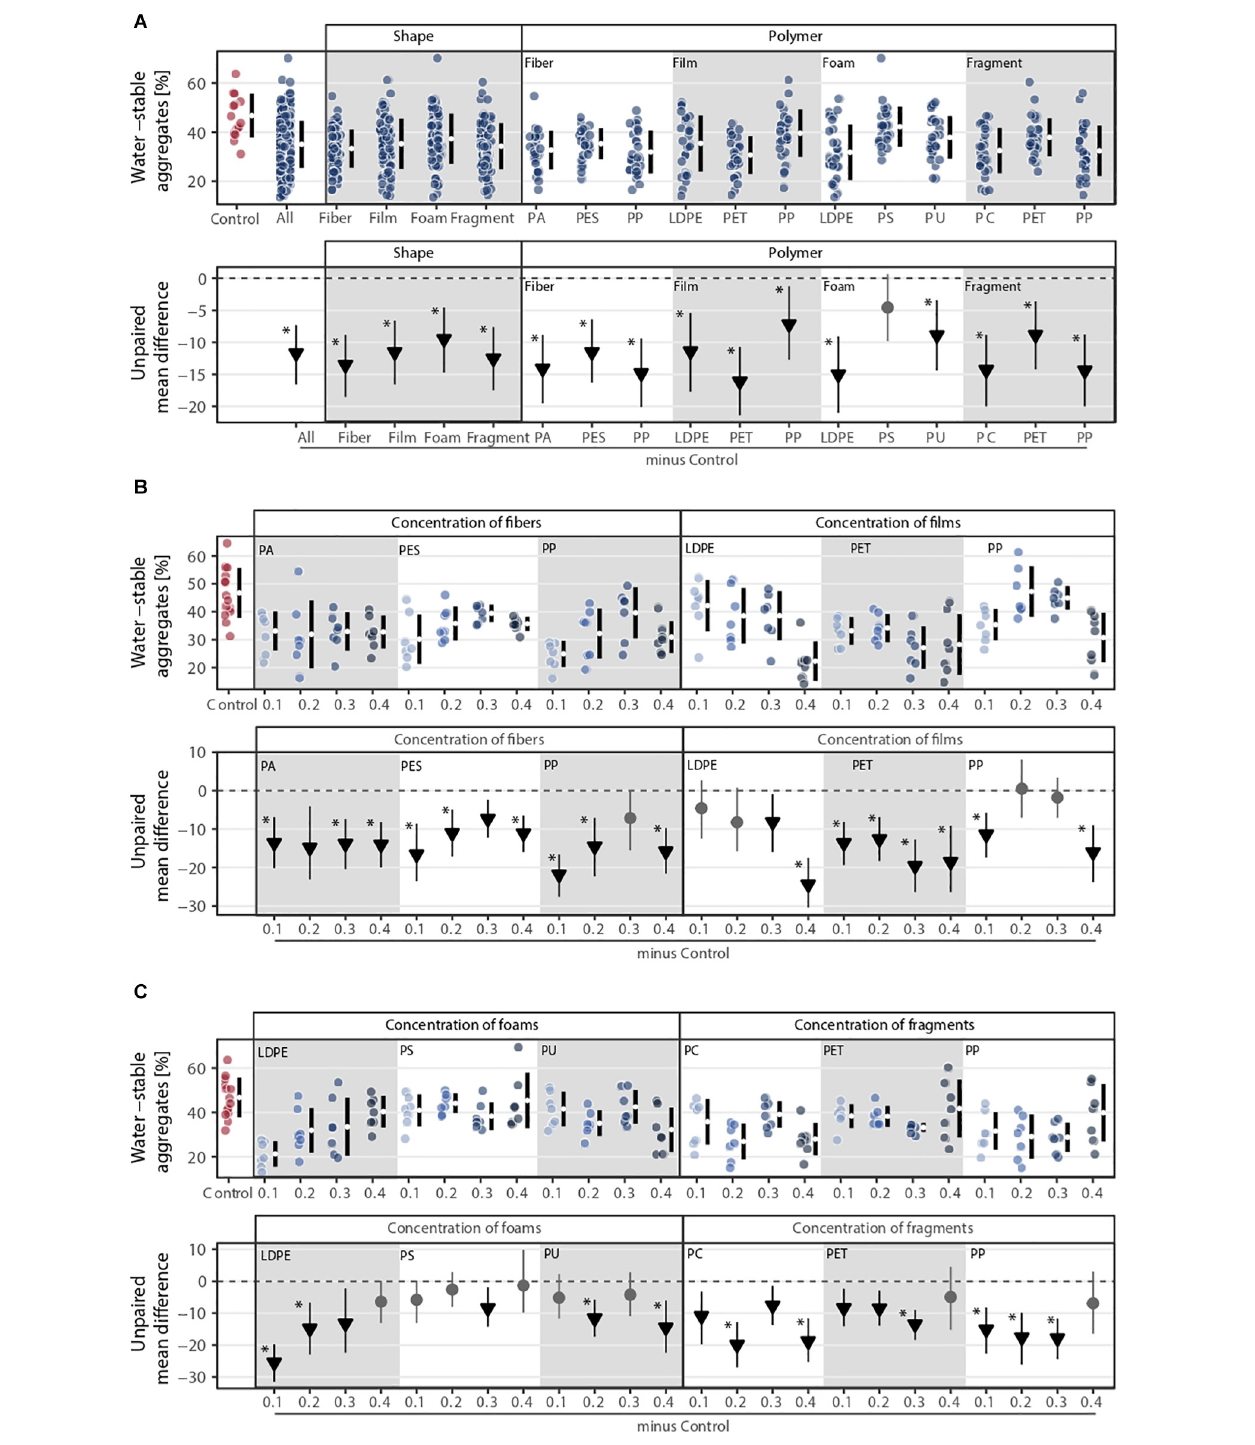
FIGURE 4 | Soil aggregation (i.e., water-stable aggregates) response to (A) microplastic shape and polymer type at (B–C) different concentrations (0.1, 0.2, 0.3, and 0.4%). That is, (B) concentration of fibers and films and (C) concentration of foams and fragments. Effect sizes and their variance are displayed as means and 95% confidence intervals. Effects are color-coded: gray circles indicate neutral effect sizes and black arrows with an arrow head pointing downward indicate negative effects; no positive effects were detected. Horizontal dotted line indicates the mean difference value between each microplastic and the control. Polymers: PA (polyamide), PES (polyester), PP (polypropylene), LDPE (low density polyethylene), PET (polyethylene terephthalate), PS (polystyrene), PU (polyurethane), and PC (polycarbonate). Significance was established at 0.05 ( Supplementary Tables S1–S3 ); n = 7 for microplastics, n = 14 for control samples.